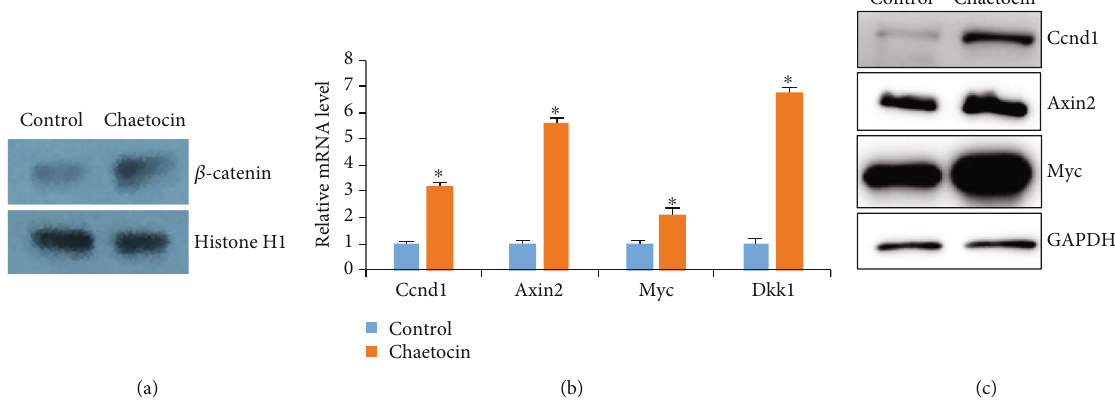
Figure 3: Treatment of Chaetocin increase Wnt/ β -catenin activities. (a) Western blot shows nuclear β -catenin protein levels were elevated by Chaetocin treatment in MSC culture at day 7. Histone H1 was used as a loading control. (b) Real-time RT-PCR analysis shows that Wnt/ β - catenin target genes (Cnnd1, Axin2, Myc, and Dkk1) were signi fi cantly increased by treatment with Chaetocin. PCR data is expressed as means ± s : d : of three independent experiments ( ∗ p < 0 : 05 ). (c) WB results show that Cnnd1, Axin2, and Myc were signi fi cantly increased after Chaetocin treatment.